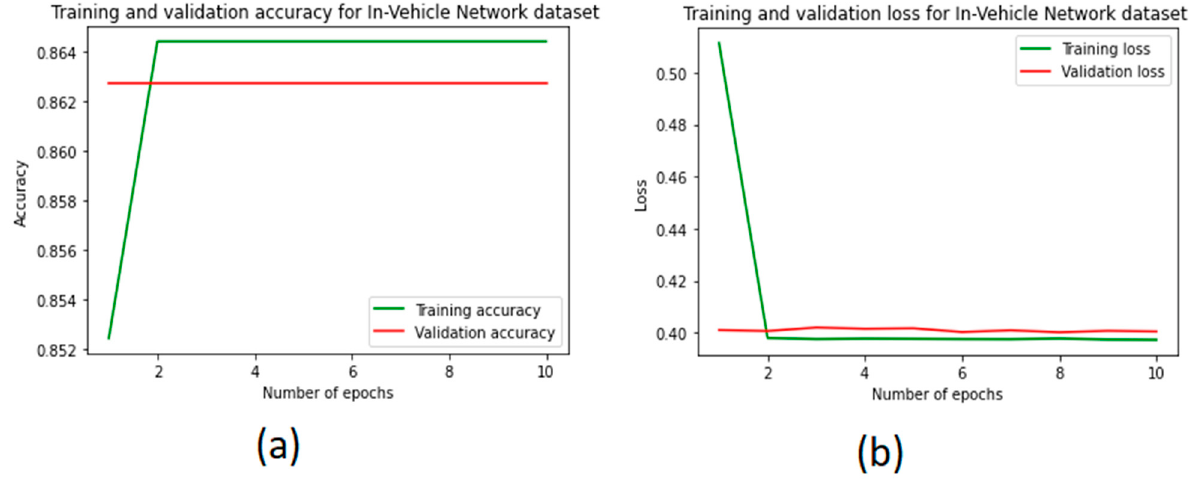
Figure 9. The performance of the CNN model: ( a ) accuracy performance and ( b ) training loss and validation.